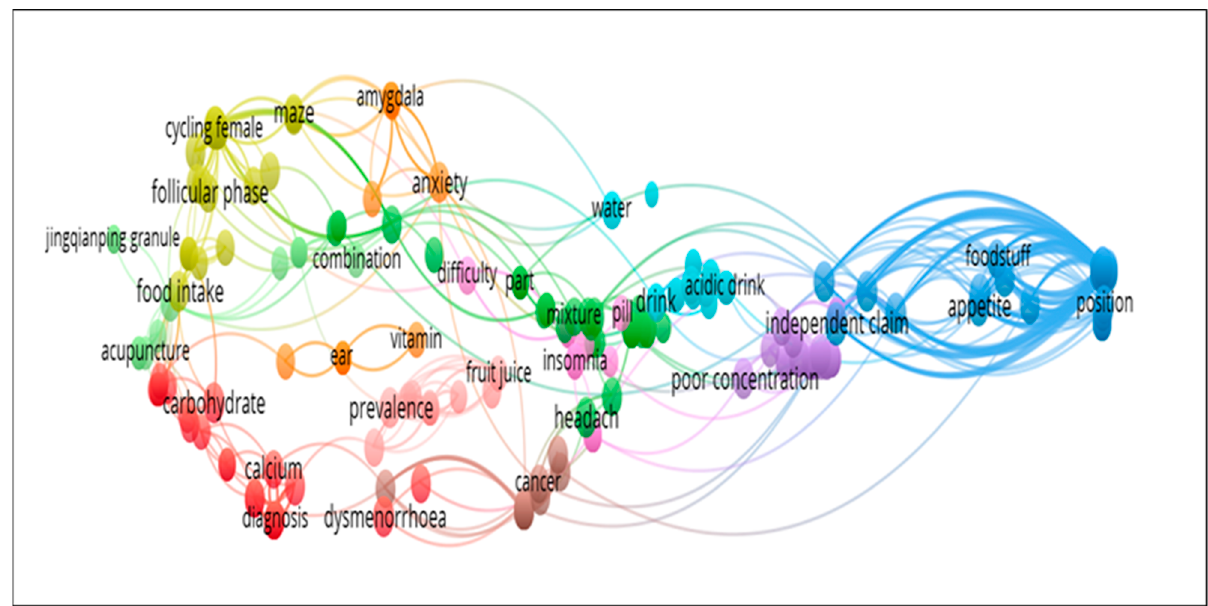
Figure 14. Network visualization based on previously published studies for the collection of the closest terms.